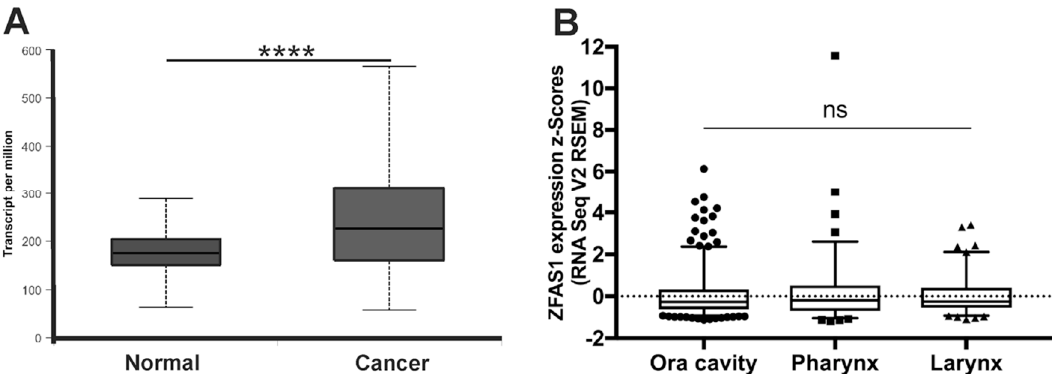
Figure 1. ( A ) Microscopic pictures of dysplastic oral keratinocyte (DOK), SCC-25, SCC-040, and FaDu cell lines, magnification 20×; ( B ) the capacity of spheres forming and ( C ) expression level of